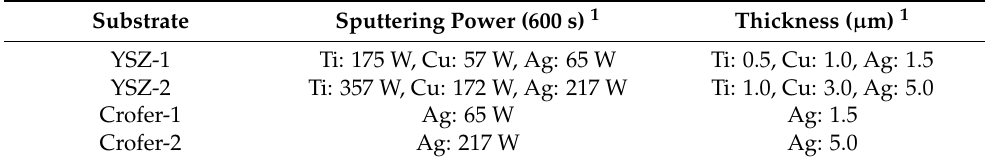
Table 1. Sputtering parameters and thicknesses of coating layer(s) on YSZ and Crofer substrates.